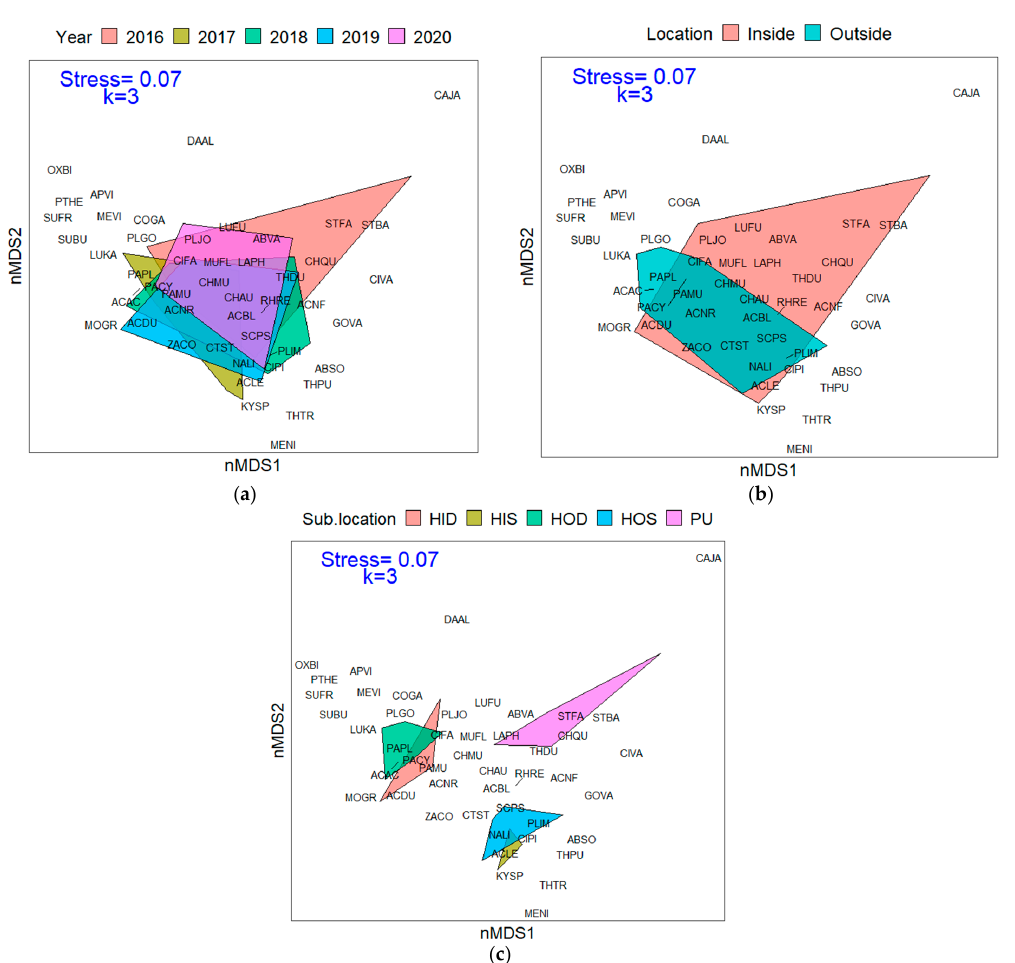
Figure 2. Non-metric multidimentional scaling (nMDS) plots of overall fish species assemblages by ( a ) 5 years, ( b ) inside or outside, and ( c ) sub-location divisions with depth incorporated. Clear spatial patterns in overall fish asseblages are evident in the sub-location nMDS. See Table A1 for species code identification. Sub-location codes are as follows: H ā ʻ ena Inside Deep (HID), H ā ʻ ena Inside Shallow (HIS), H ā ʻ ena Outside Deep (HOD), H ā ʻ ena Outside Shallow (HOS), and Pu ʻ uhonua (PU; located within H ā ʻ ena Inside Shallow).